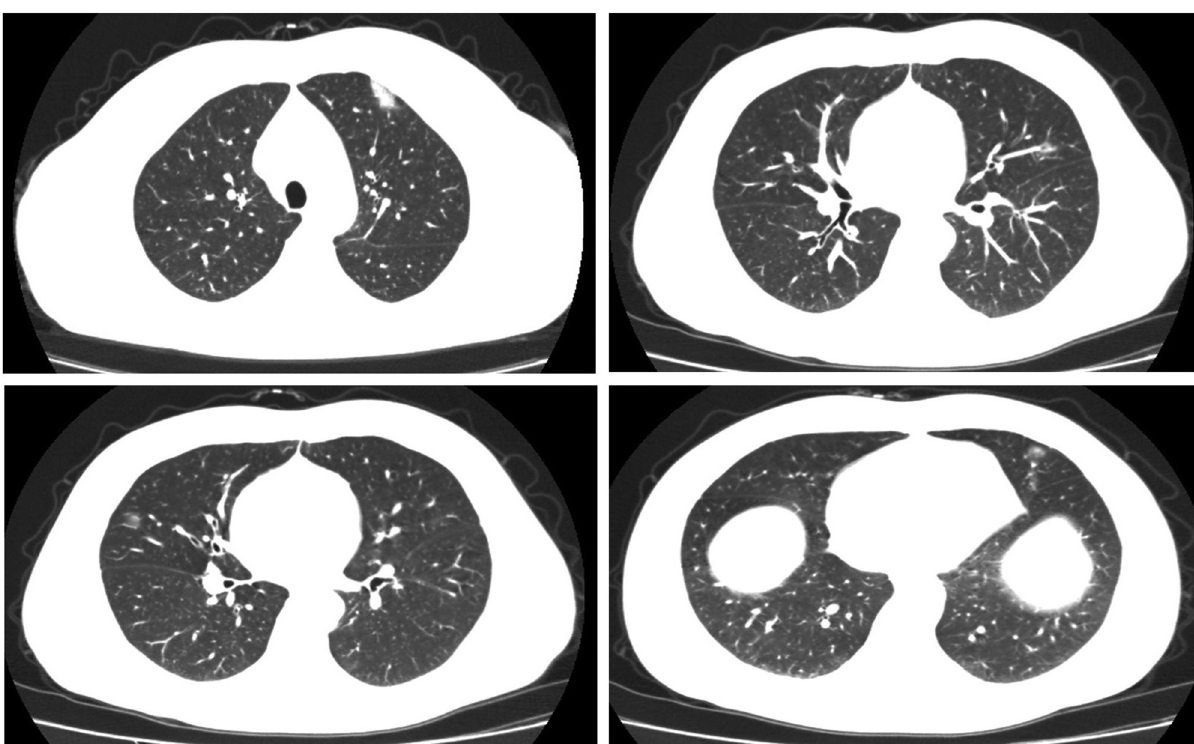
Figure 2: Case 2: CT chest result showed multiple peripheral ground - glass images on bilateral